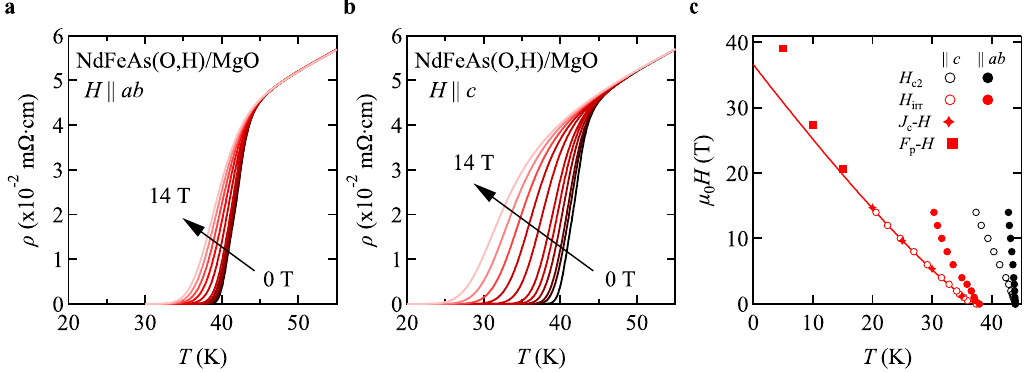
Figure 2. Temperature dependence of the resistivity at various magnetic fields for the NdFeAs(O,H) epitaxial thin film. Direction of the applied fields H parallel to ( a ) the ab -plane and ( b ) the c -axis. ( c ) Magnetic phase diagram. Irreversibility fields determined from the field dependence of J c and the corresponding F p for H || c follow well the irreversibility field line down to 20 K, which is expressed by Eq. (1).